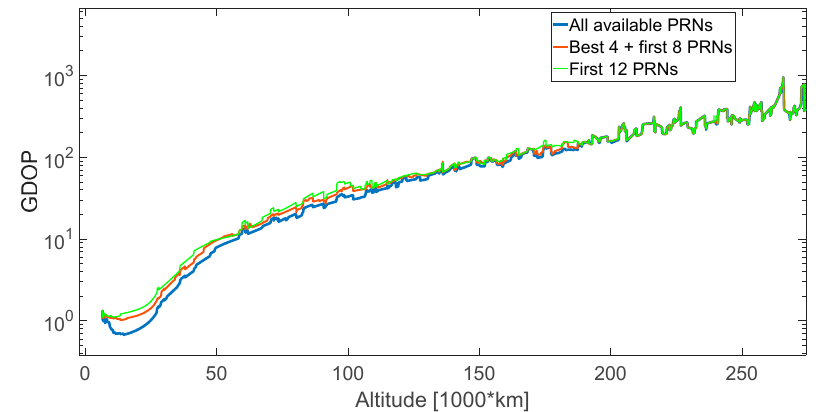
Figure 45. GDOP in three different cases: when all the available signals are processed (in blue), when only the first 12 signals available are processed (in green, i.e., chronologically the first 12 available from 1 to 29), when the four signals that provide the lowest GDOP are included in the 12 processed (in brown).